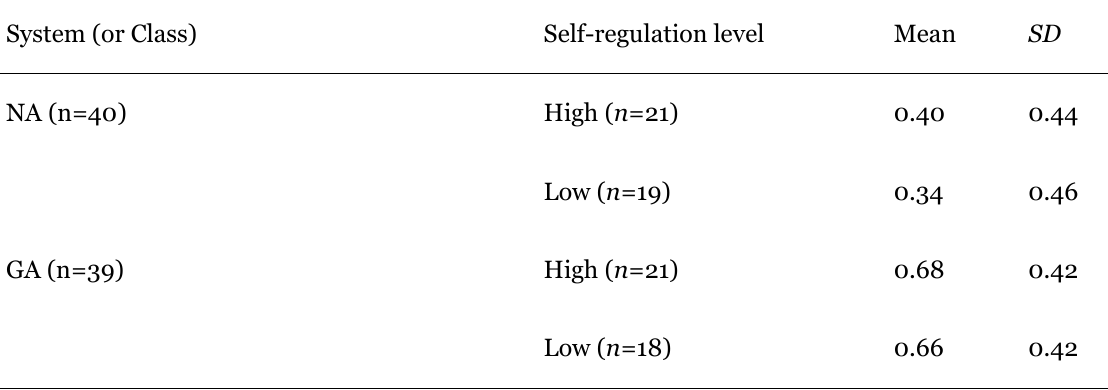
Descriptive Statistics of Responding Rate (n=79)